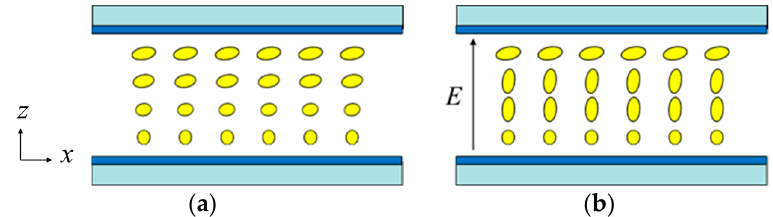
Figure 4. The LC director orientations in the 90° TN mode: ( a ) Voltage-off state; ( b ) Voltage-on state.